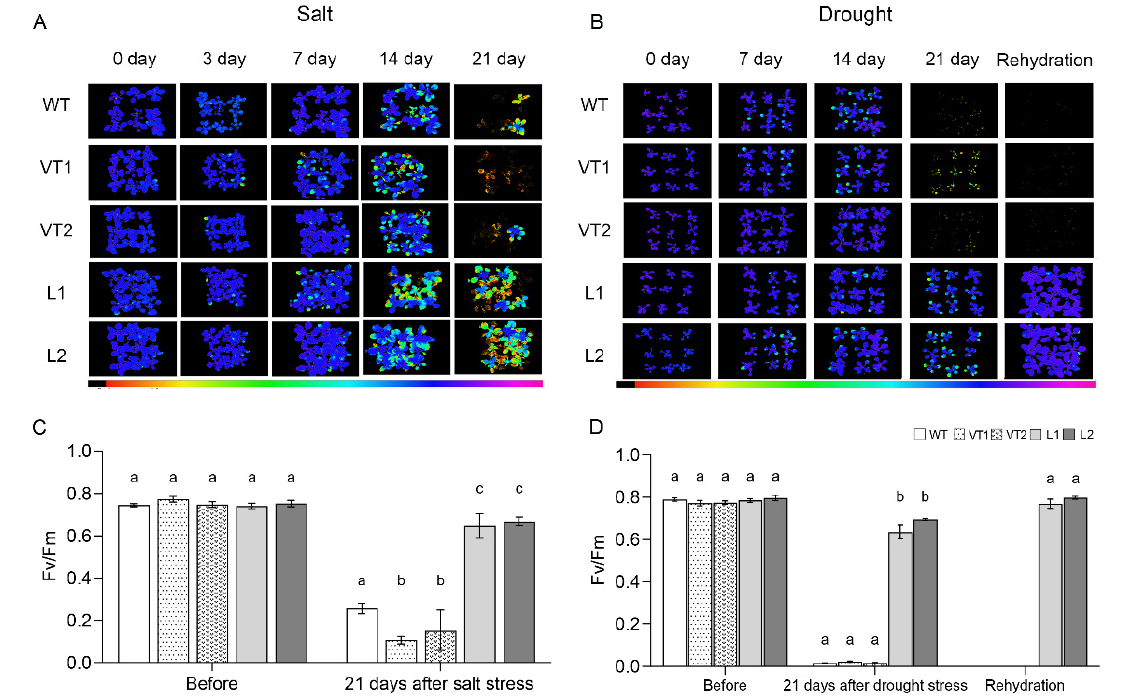
Figure 6. Chlorophyll fluorescence analysis of wild and transgenic Arabidopsis under stress. Chloro- phyll fluorescence imaging of wild and transgenic Arabidopsis under ( A ) salt treatment; ( B ) drought treatment. Blue light means that the photosynthesis of the plant is proceeding normally, yellow light means that the photosynthesis of the plant is affected. IMAGING-PAM measures fluorescence imaging on an area of 10 × 13 cm. Column statistics of Fv/Fm values for wild and transgenic Arabidopsis under ( C ) salt treatment; ( D ) drought treatment. The data were means ± SD from three independent replications. Different lowercase letters indicate significant differences between different columns under the same treatment conditions ( p < 0.05).